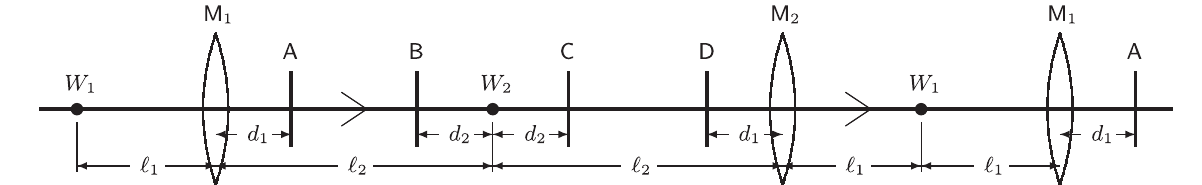
PERFORMANCE OF THE X-RAY FREE-ELECTRON LASER . .